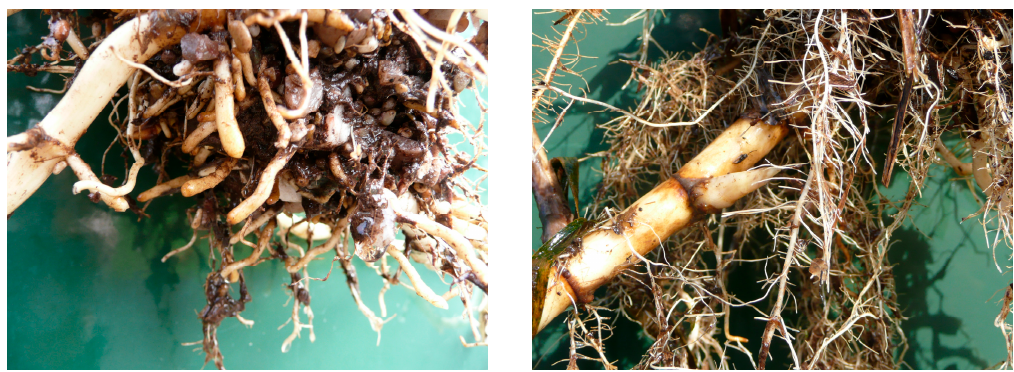
Figure 8. Root balls of Phragmites australis from an aerated wetland (L) and a non-aerated wetland (R) at Rugeley (UK) in 2013.